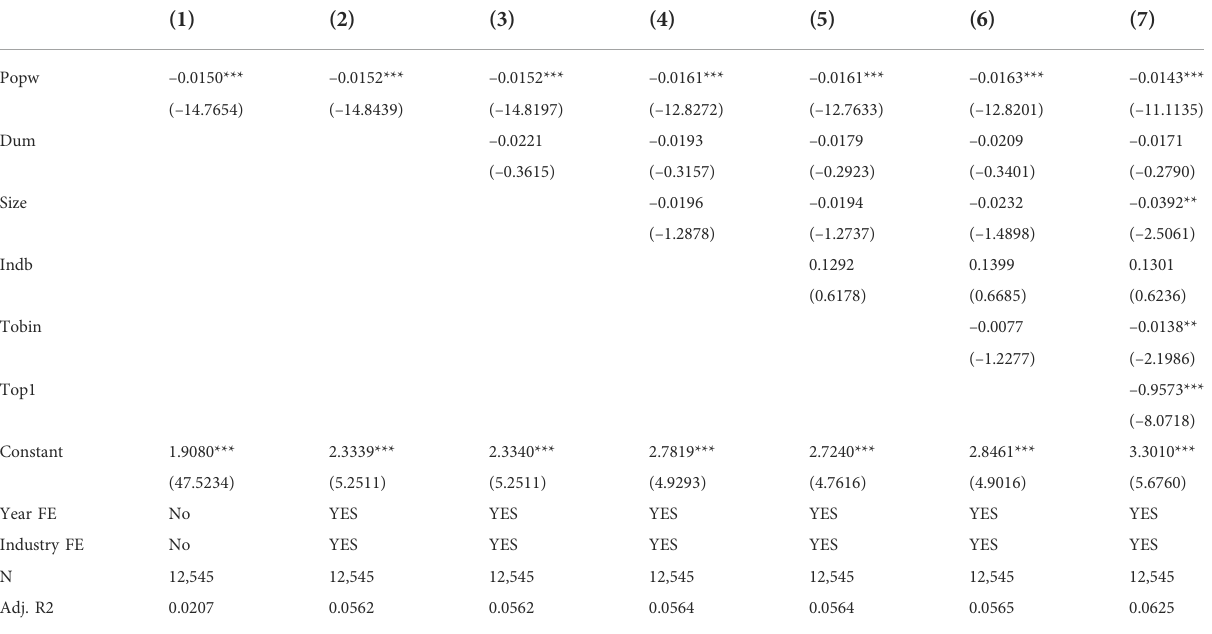
TABLE 6 Replace the variable of company risk-taking